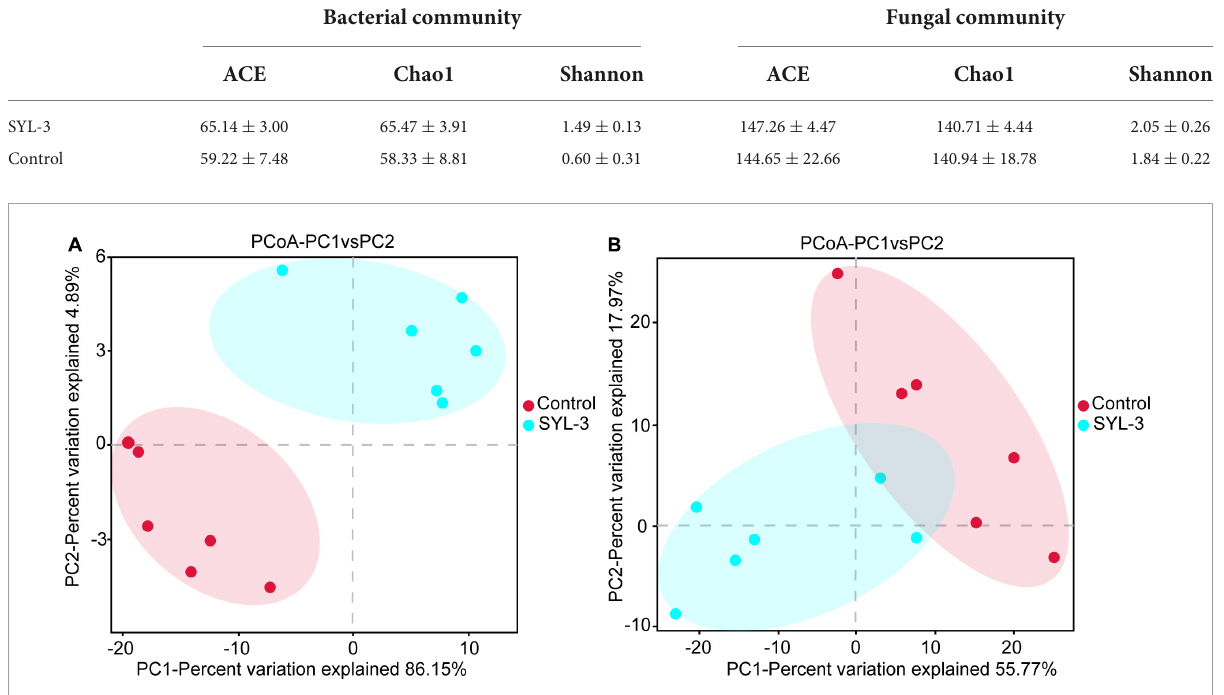
FIGURE6 Taxonomic beta-diversity of phyllosphere microbial community as indicated by principal coordinates analysis (PCoA) plots. (A) PCoA analysis of bacterial community. (B) PCoA analysis of fungal